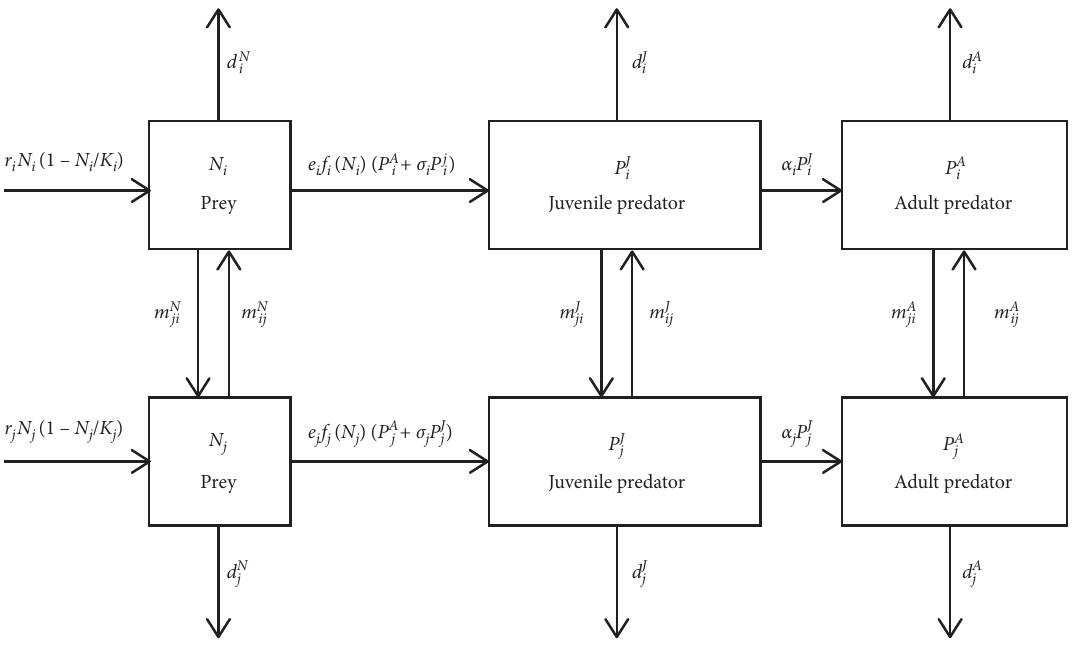
Figure 1: Flowchart of the dispersal process between patch i and j